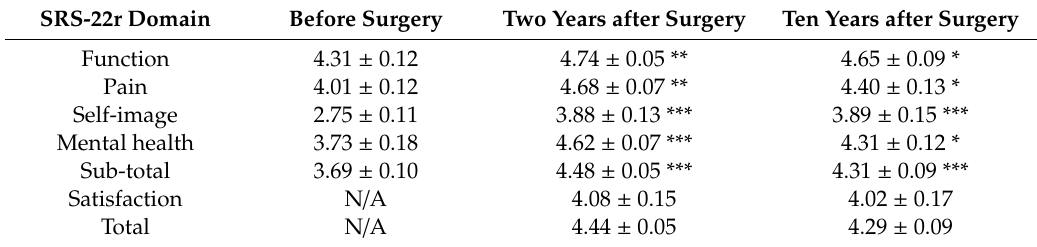
Table 3. Clinical results of SRS-22r scores.